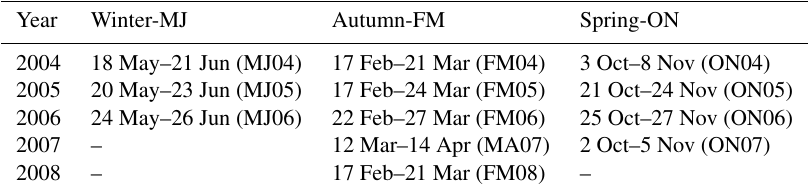
Figure 4. (a) Histograms of sea-ice thickness from ASPeCt and three reanalyses. Locations of model sea-ice thickness are shown in (b) GECCO2 for a range of 0.8 to 1.4m, (c) NEMO-EnKF for a range of 1.1 to 1.7m and (d) GIOMAS for a range of 1.1 to 1.7m. Table 2. ICESat-1 measurement periods in this study. Abbreviations given in parentheses in each cell are used throughout the paper to denote the respective period. Spring-ON refers to October and November, Autumn-FM refers to February and March, and Winter-MJ refers to May and June.